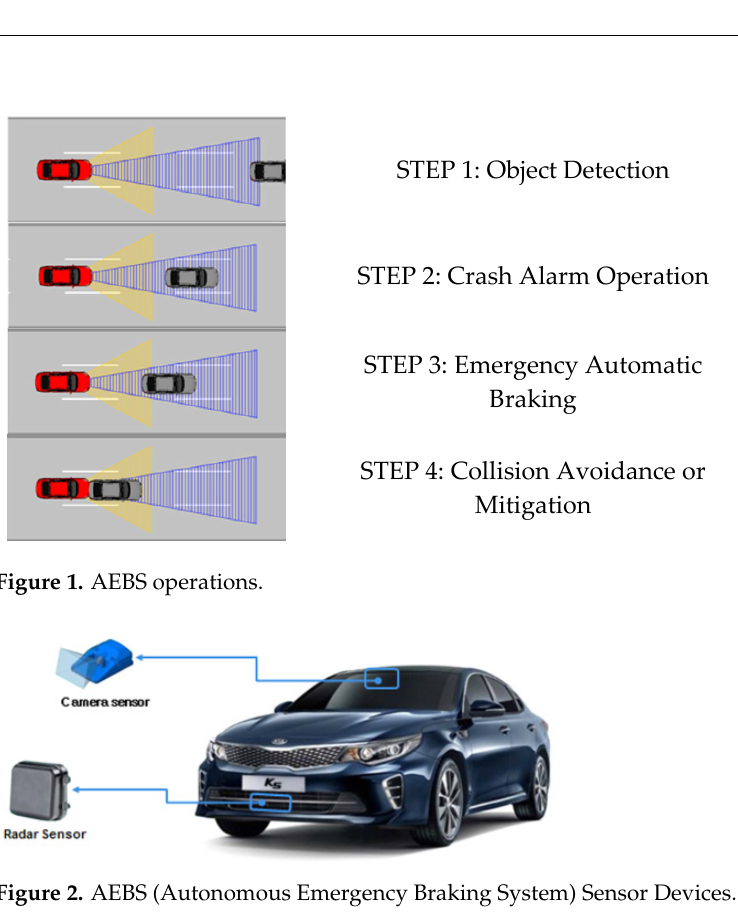
Figure 2. AEBS (Autonomous Emergency Braking System) Sensor Devices.